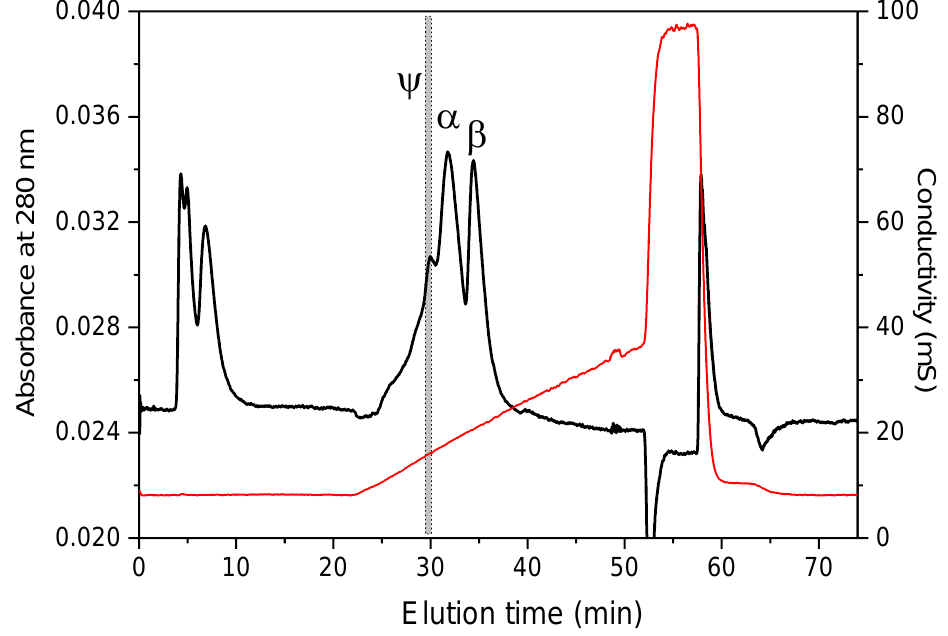
Figure 2. Ion-exchange chromatography of trypsin autolyzate. The depicted separation was performed on a Uno S12 column (15 × 68 mm; Bio-Rad, Hercules, CA, USA) using a linear gradient of NaCl (0–1 M) in 100 mM Tris-HCl, pH 7.1, containing 10 mM CaCl 2 . The gray box indicates a time window, in which the respective ψ-trypsin fraction was collected. The black line shows absorbance at 280 nm, the red line refers to conductivity of the eluate.